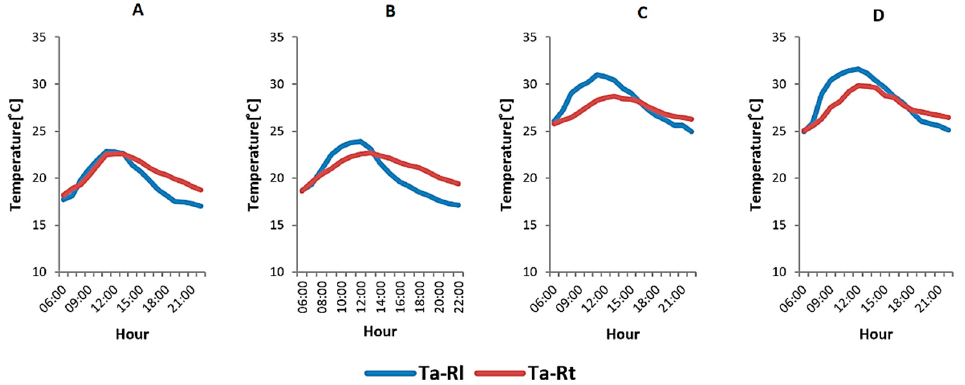
Figure 5. Data of wet season measurement results, ( A ) exposed stone houses in the mountains, ( B ) wooden houses in the mountains, ( C ) exposed brick houses on beaches, and ( D ) wooden houses on beaches.